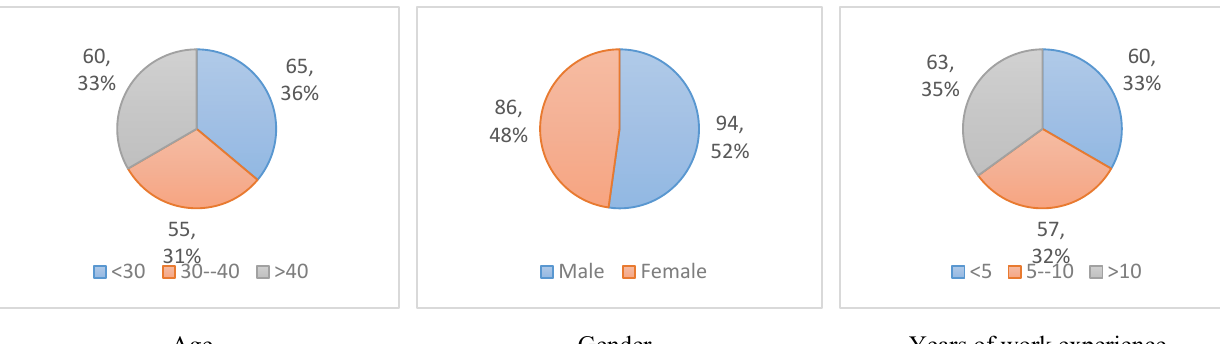
Fig. 2. Personal characteristics of the